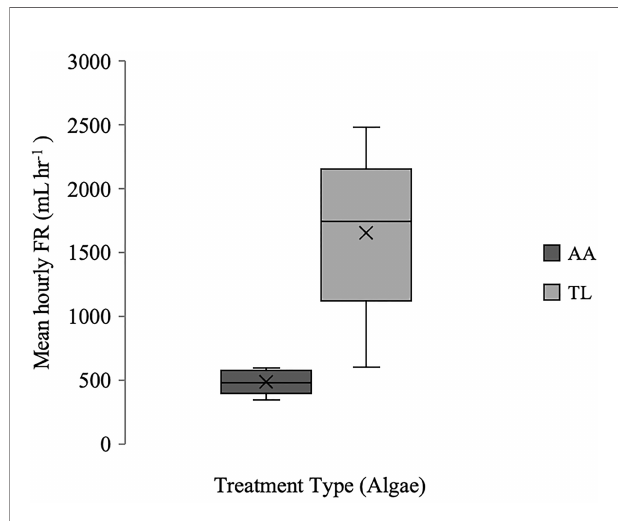
FIGURE 3 | Boxplot (x = mean, n=10) of hourly FR (mL hr -1 ) for Styela plicata exposed to Aureococcus anophagefferens (AA) or Tisochrysis lutea (TL, control).